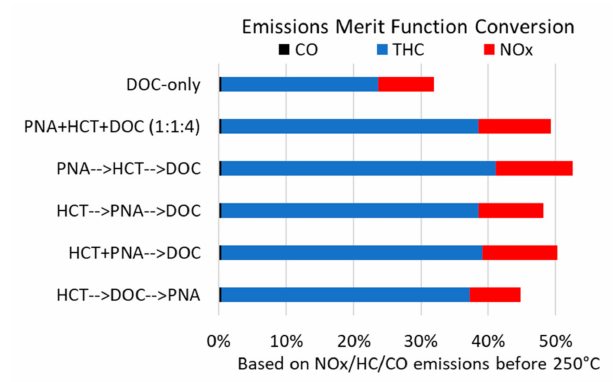
Figure 8. ( a ) Average weighted emissions conversion rate up to 250 ◦ C, as calculated from the parameters in Table 1 and Equations (1) and (2), for a series of multibed reactor systems; ( b ) also shows the emissions when normalized to PGM content. Contributions from ( (cid:4) ) CO, ( (cid:4) ) THC, and ( (cid:4) ) NOx are shown as a portion of the total for each graph.